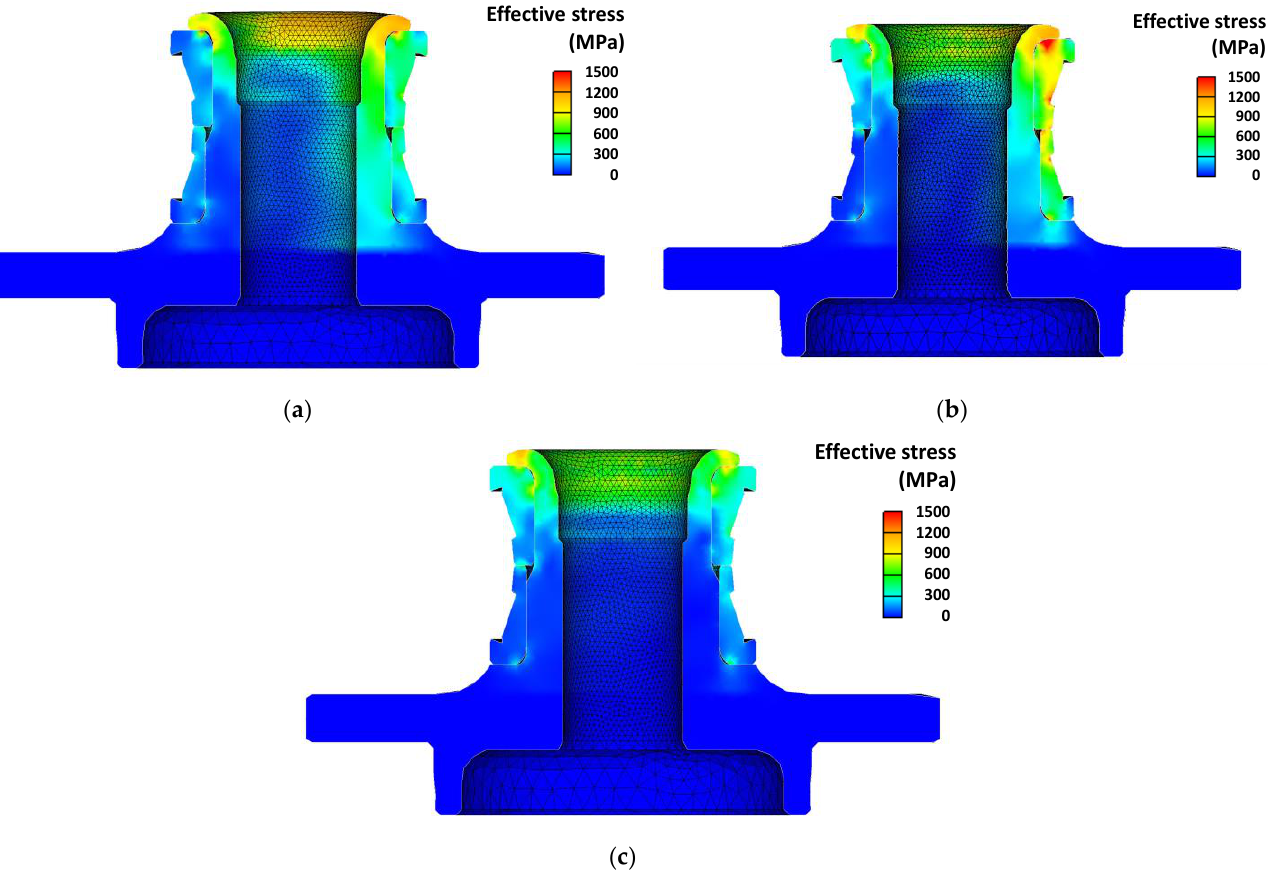
Figure 6. Residual stresses: ( a ) At commencement of homogenizing; ( b ) at the final homogenizing stroke; ( c ) after homogenizing.